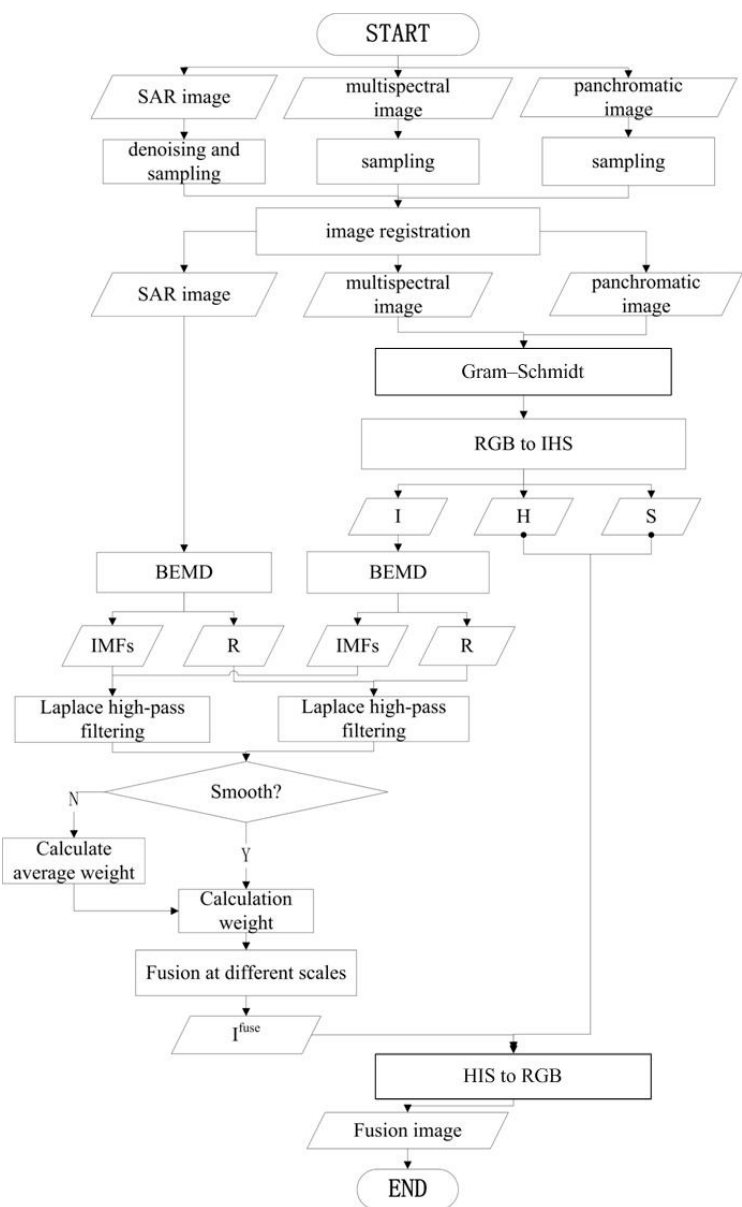
Figure 2. Flowchart of image fusion based on bidimensional empirical mode decomposition (BEMD). IMF: intrinsic mode functions.